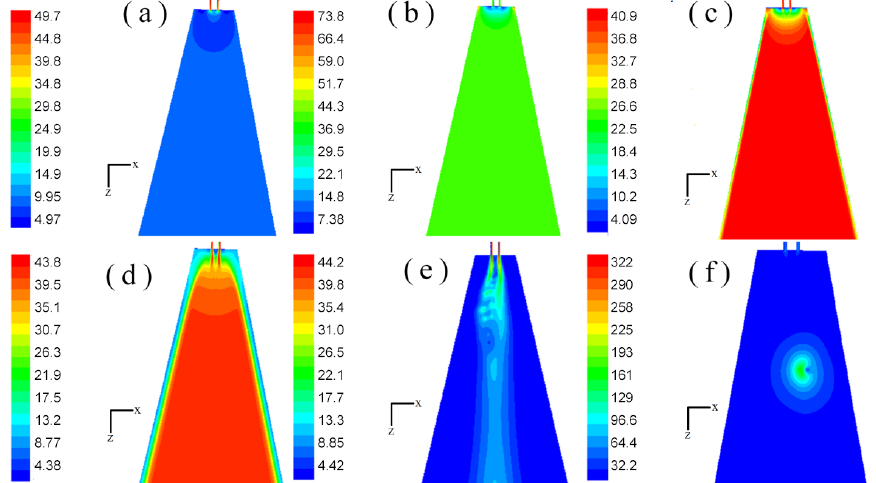
Polymers 2022 , 14 , x FOR PEER REVIEW